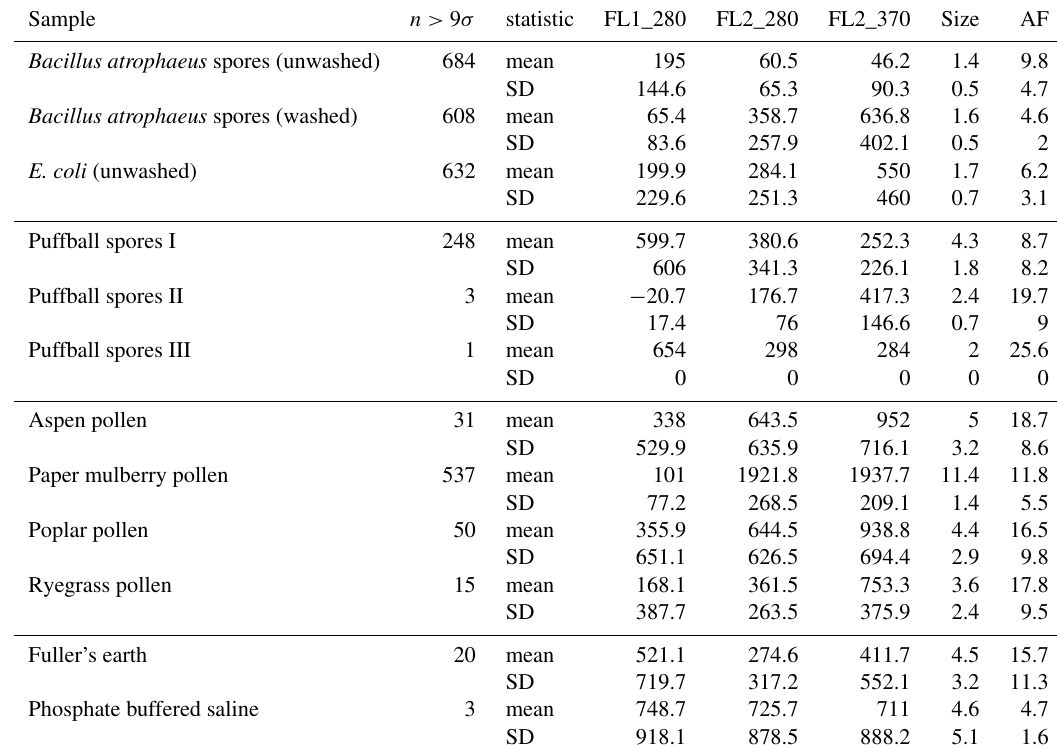
Table C4. Summary of particle measurements for the 2014 data set using a fluorescent threshold of 9 σ